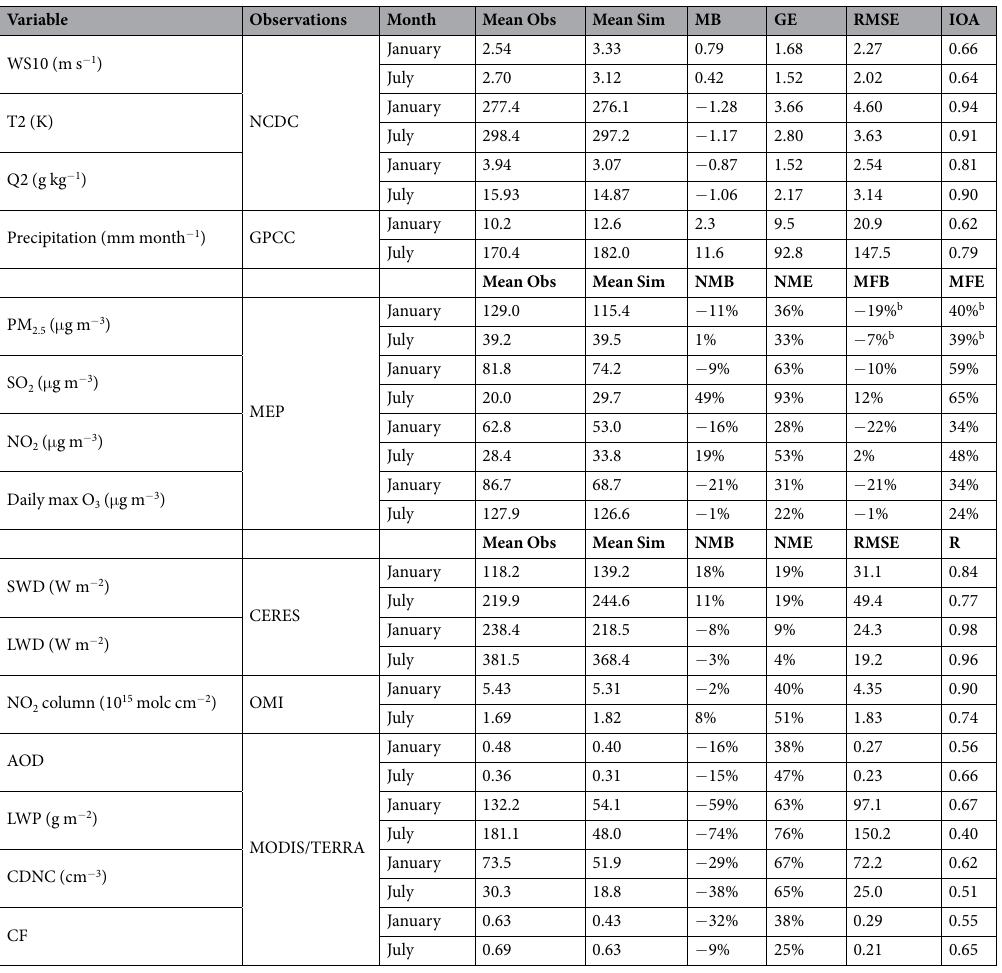
Table 1. Statistics of model performance for meteorological and chemical predictions for the baseline scenario (BASE). a WS10, wind speed at 10 m; T2, temperature at 2 m; Q2, water vapor mixing ratios at 2 m; SWD, downward shortwave radiation at surface; LWD, downward longwave radiation at surface; AOD, aerosol optical depth; LWP, liquid water path; CDNC, cloud droplet number concentration; CF, cloud fraction; MB, mean bias; GE, gross error; RMSE, root mean square error; IOA, index of agreement; NMB, normalized mean bias; NME, normalized mean error; R, correlation coefficient; MFB, mean fractional bias; MFE, mean fractional error; NCDC, National Climatic Data Center; CERES, Clouds and the Earth’s Radiant Energy System; GPCC, Global Precipitation Climatology Center; OMI, Ozone Monitoring Instrument; MODIS, Moderate Resolution Imaging Spectroradiometer; MEP, Ministry of Environmental Protection of China. b Boylan and Russell 36 proposed a model performance criteria of MFE ≤ + 75% and MFB ≤ ± 60%, and a model performance goal of MFE ≤ + 50% and MFB ≤ ±